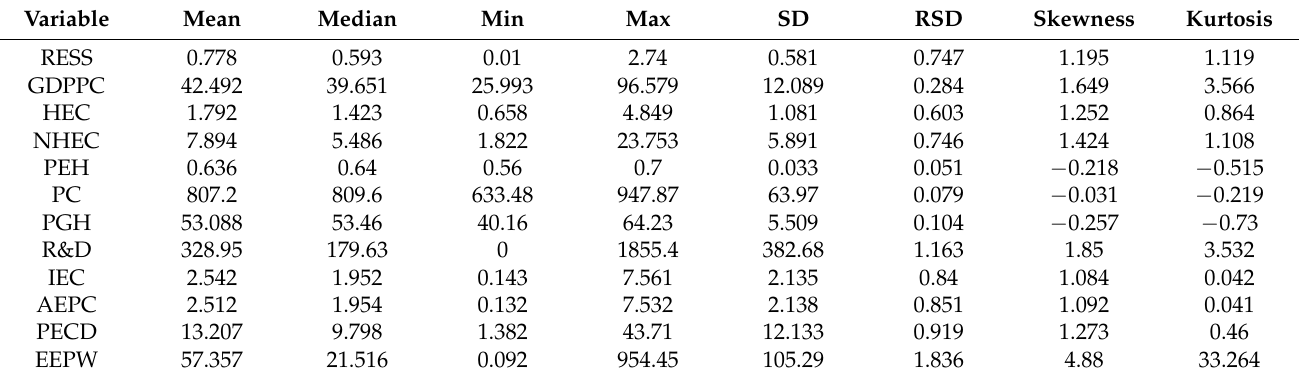
Table A1. Summary statistics—variables per voivodeship in Poland in